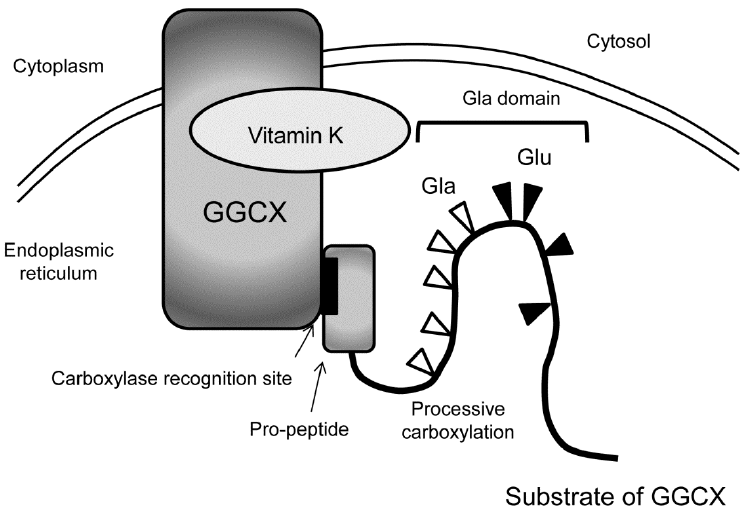
Figure 3. Processive γ -carboxylation of typical GGCX substrates. In the endoplasmic reticulum, typical substrates of GGCX bind with GGCX with the carboxylase recognition site in the pro-peptide at their N-termini (indicated by arrows). Then, multiple glutamate residues (Glu, black triangles) in the Gla domain are converted into Gla residues (white triangles) in processive manner.